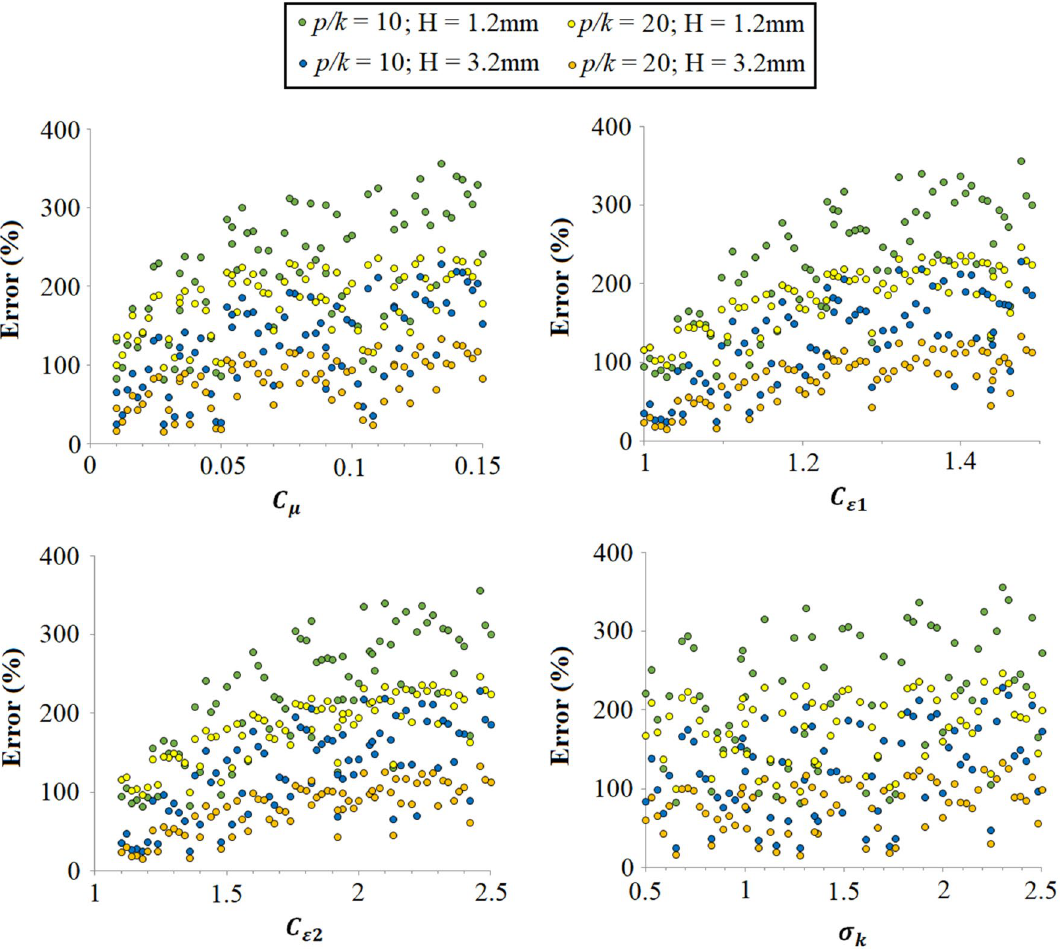
Fig. 10 Absolute values of relative errors in predicting the friction factor with κ-ε turbulent